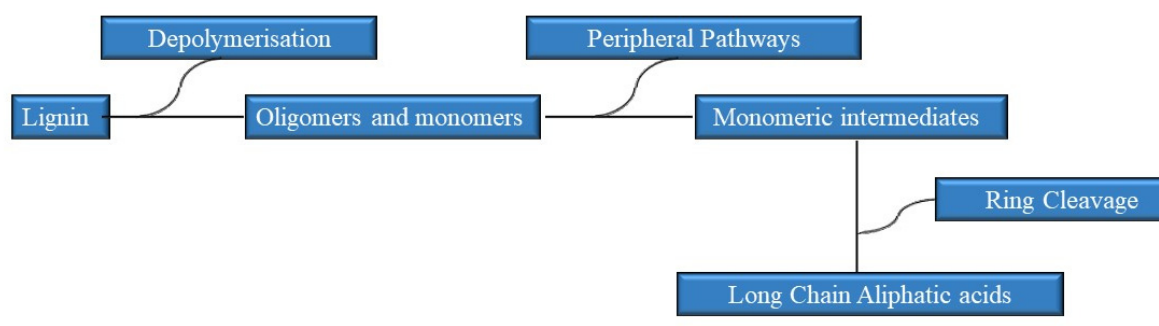
Figure 19. Step-wise process of the depolymerization of Lignin [86].